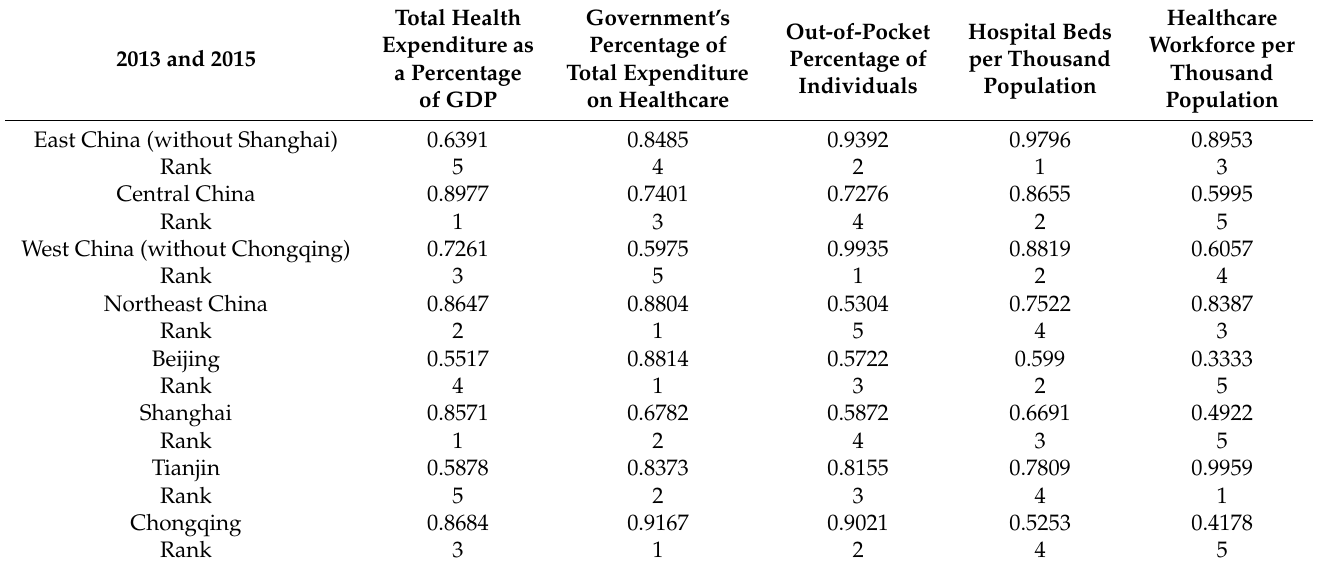
Table 5. Grey Relation Degree and Ranking of the Healthcare Resource Factors for Public Satisfaction with Health System in eight regions of China (Year 2013 and 2015, Deng’s GRA